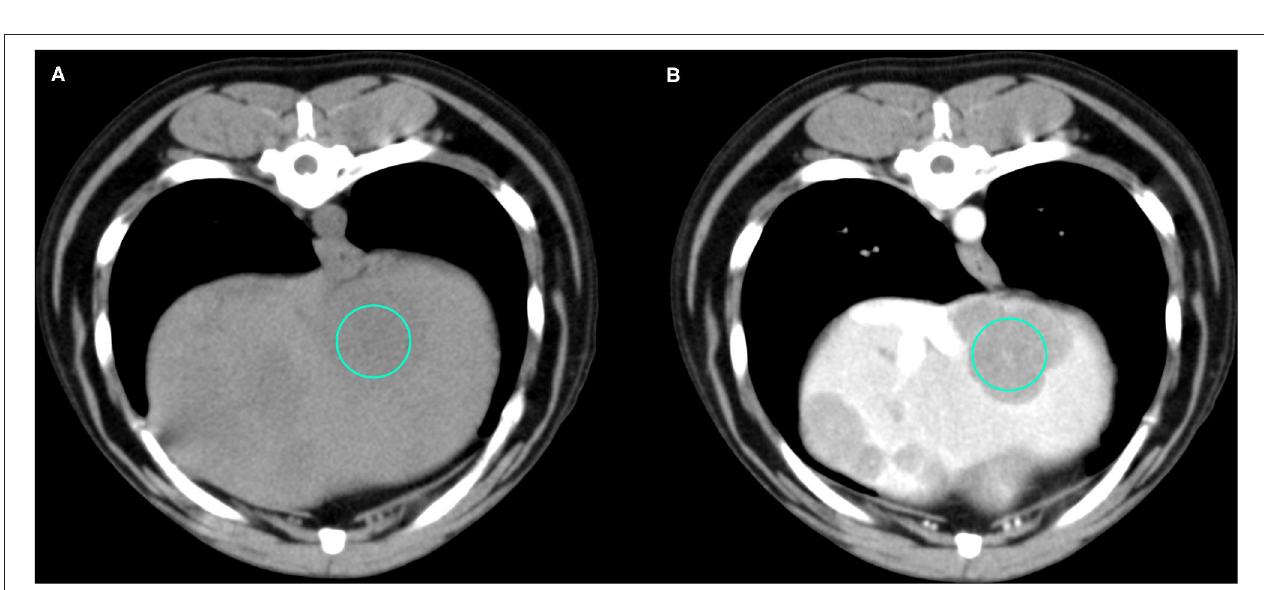
FIGURE 3 | Example of an HCC showing hypoattenuation and hypoenhancement, diffuse contrast enhancement pattern, with heterogeneous distribution, well-defined margins, irregular surface, and cyst-like appearance. (A) image obtained from the pre-contrast scan; (B) image obtained from the delayed scan. A ROI is placed inside the lesion in both. Based on the developed decision tree this lesion was classified as HCC.